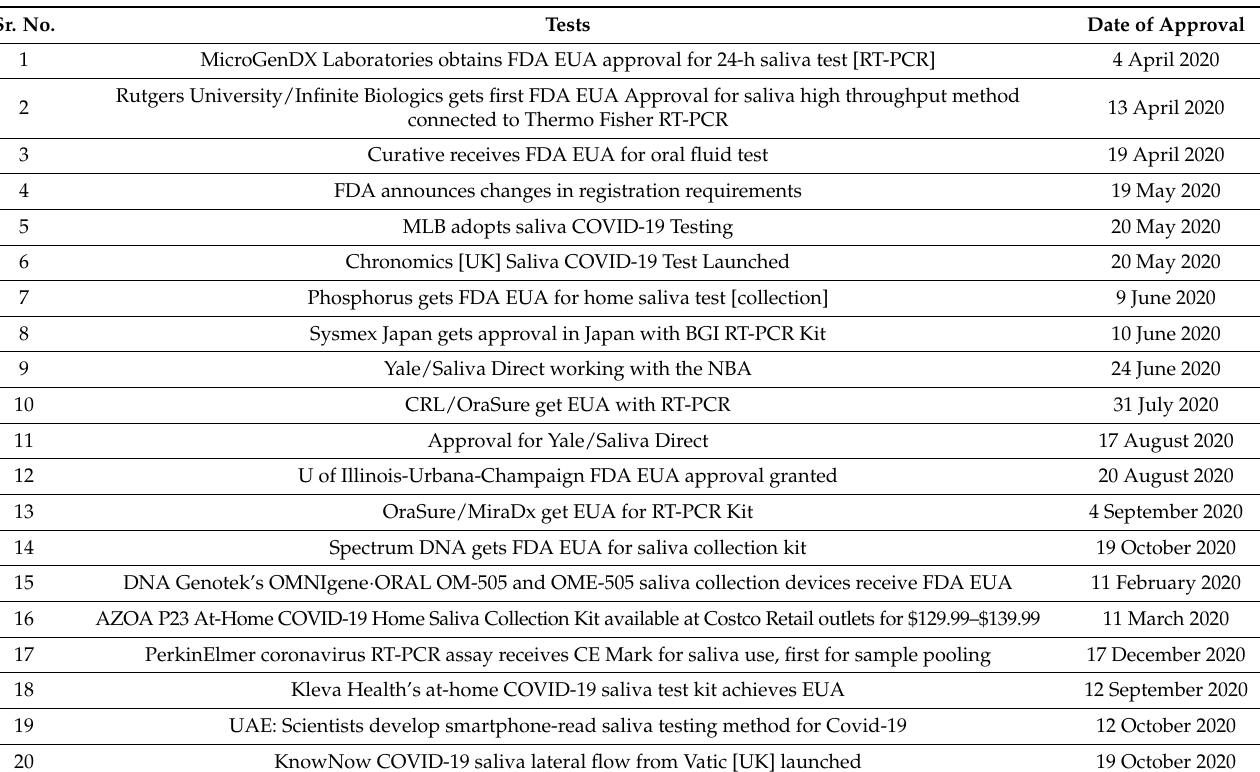
Table 1. Timeline of the saliva collection devices for the SARS-CoV-2 sampling during the pandemic. Sr.